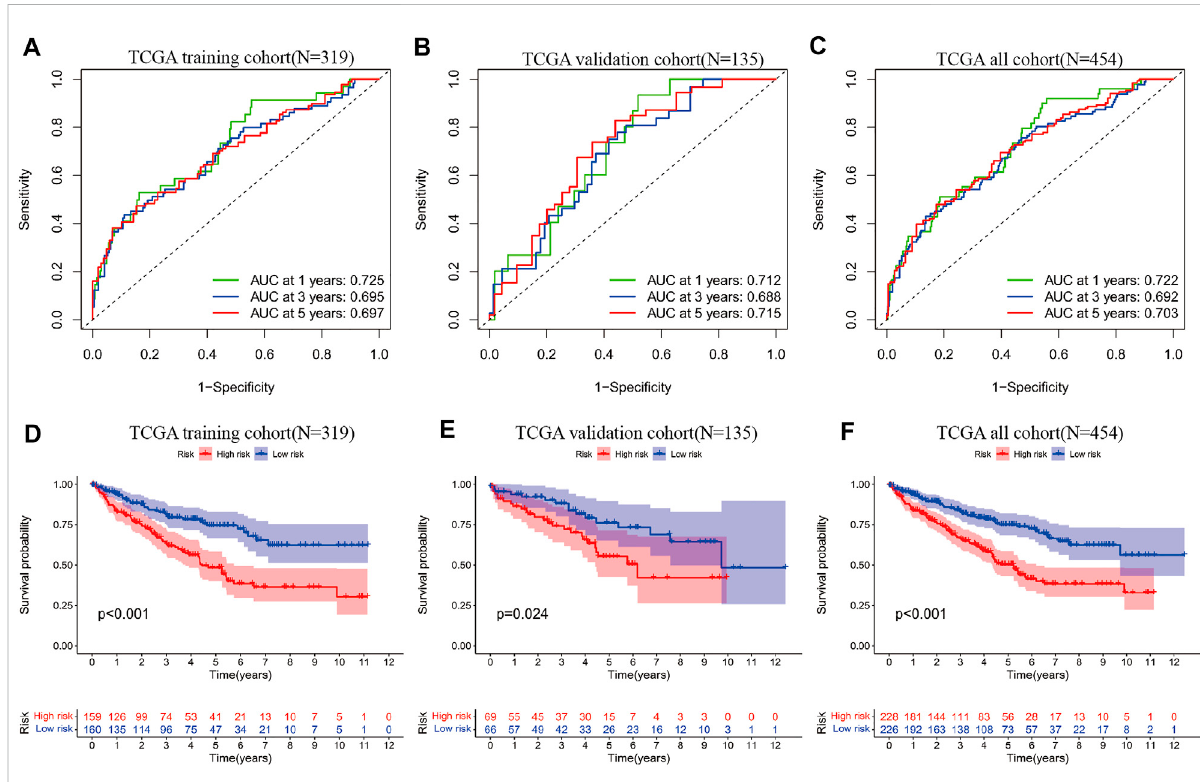
FIGURE 2 (A) ROCcurves ofSAGRIinTCGAtrainingcohort; (B) ROC curvesofSAGRIinTCGAvalidationcohort; (C) ROCcurvesofSAGRIinthefullTCGA cohort; (D) K-M survival curves of SAGRI-HIGH andSAGRI-LOW inTCGA training cohort; (E) K-M survival curves of SAGRI-HIGH and SAGRI-LOW in TCGA validation cohort; (F) K-M survival curves of SAGRI-HIGH and SAGRI-LOW in the full TCGA